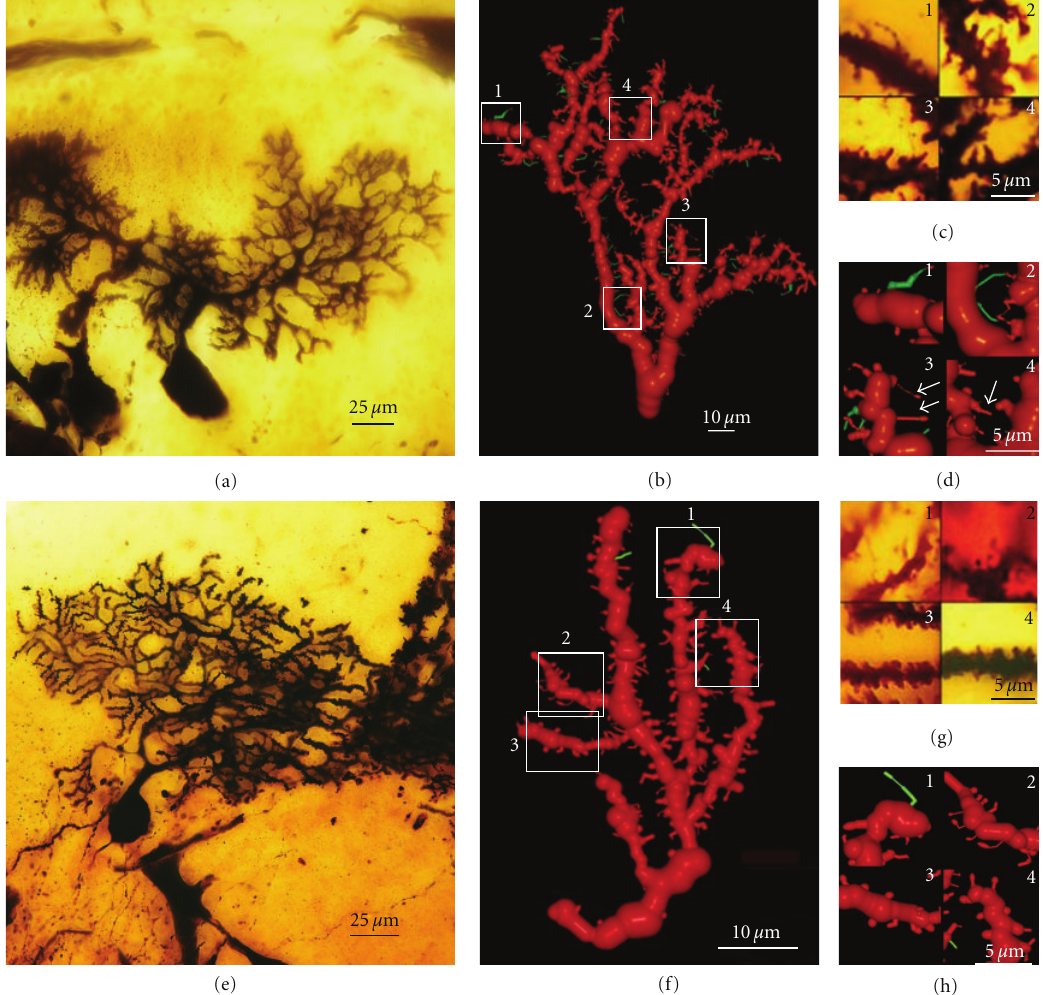
Figure 11: (a)Illustrates a Purkinje cell, 17-day-old dog, Golgimethod, Cajalhistologicalpreparation. (b) Three-dimensional reconstruction of a portion of the dendritic tree of this Purkinje cell. (c) Golgi-impregnated dendritic appendages of this Purkinje cell; 1: protospine; 2: thin dendritic spines; 3: small dendritic spines; 4: possible budding branchlets. (d) Boxed regions in (b); 1: protospine (green); 2: thin filopodia (green); 3: thin dendritic spines (arrow); 4: possible budding branchlet (arrow). (e) Purkinje cell, “cat almost adult” according to the label of the Cajal histological preparation, Golgi method. (f) Three-dimensional reconstruction of a portion of the dendritic tree of this Purkinje cell. (g) Golgi-impregnated dendritic appendages of this Purkinje cell; 1, dendritic filopodia; 2, thin dendritic spines; 3 and 4 sessile dendritic spines. (h):Boxed regions in (f); 1, dendritic filopodia; 2, thin dendritic spines; 3, 4, sessile dendritic spines and some thin dendritic